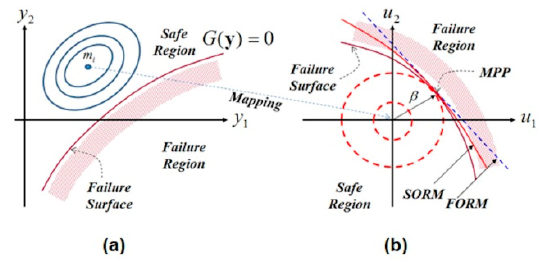
Figure 5. ( a ) Physical space and ( b ) normalized spaces.